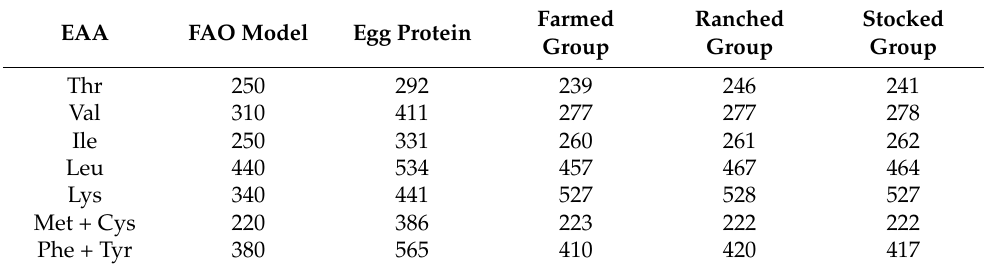
Table 3. The essential amino acid composition and content in muscle of three groups compared to the FAO model and egg protein (mg/g. N).